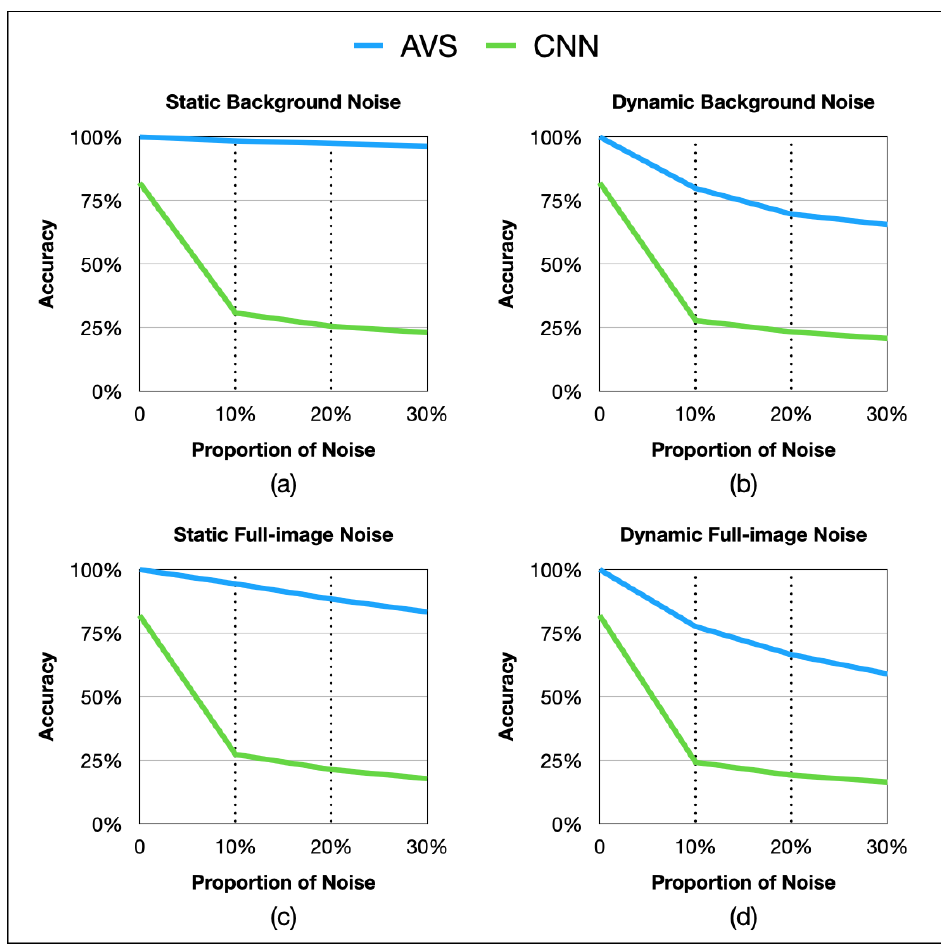
Figure 15. The motion direction detection accuracy trends of AVS and CNN to progressive propor- tions of diifferent noise types: ( a ) accuracy trends in static background noise; ( b ) accuracy trends in dynamic background noise; ( c ) accuracy trends in static full-image noise; ( d ) accuracy trends in dynamic full-image